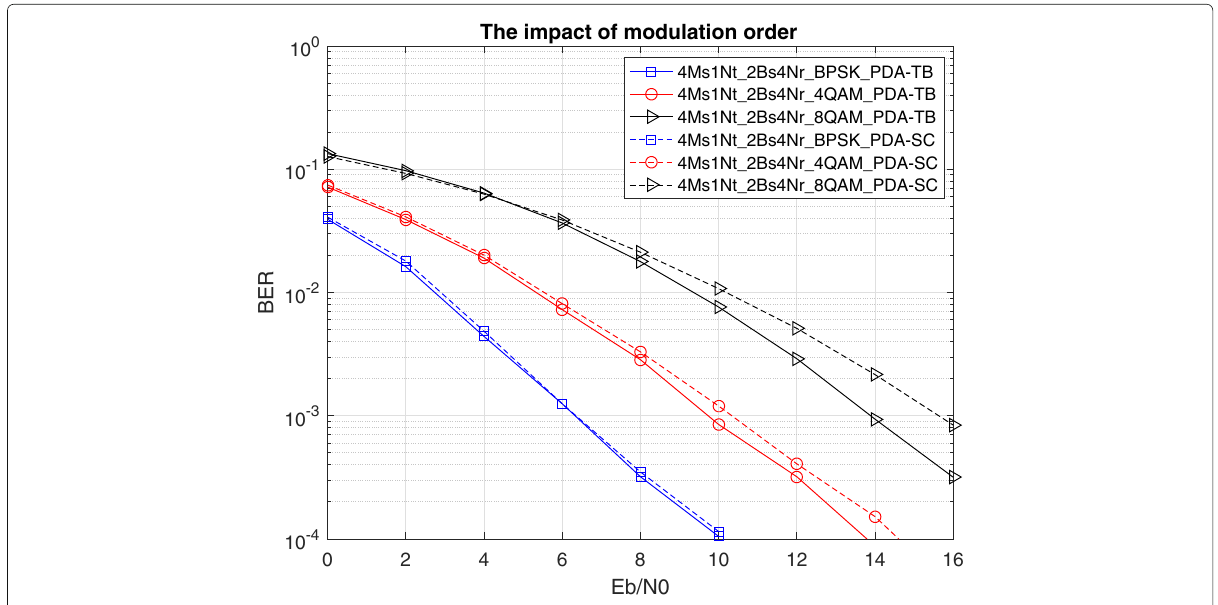
Fig. 5 The impact of modulation